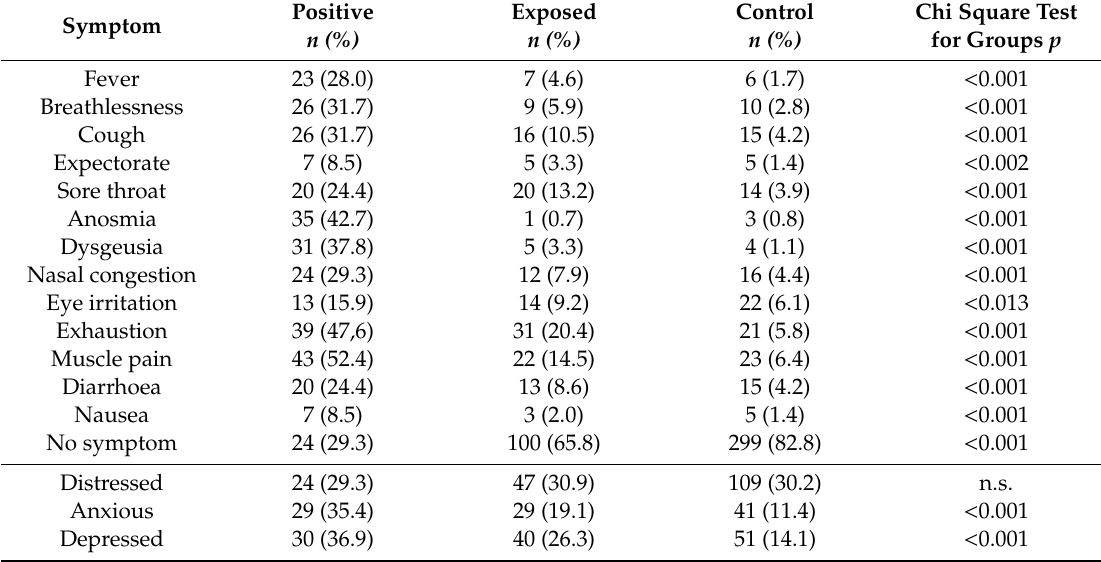
Table 3. Comparison of symptoms reported in the sub-groups of